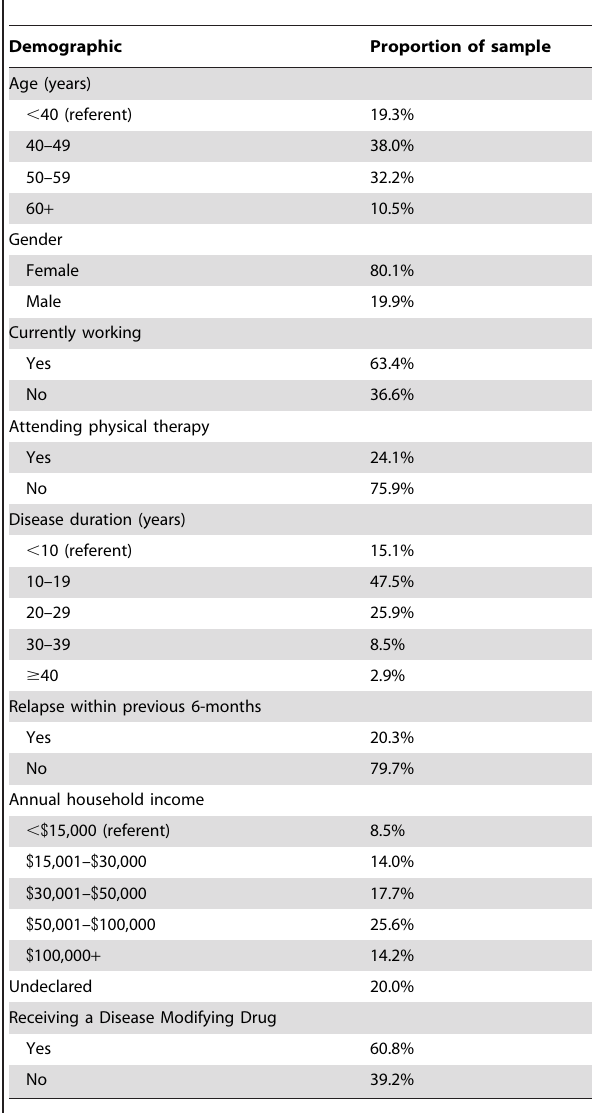
Table 1. NARCOMS Participant Demographics (n